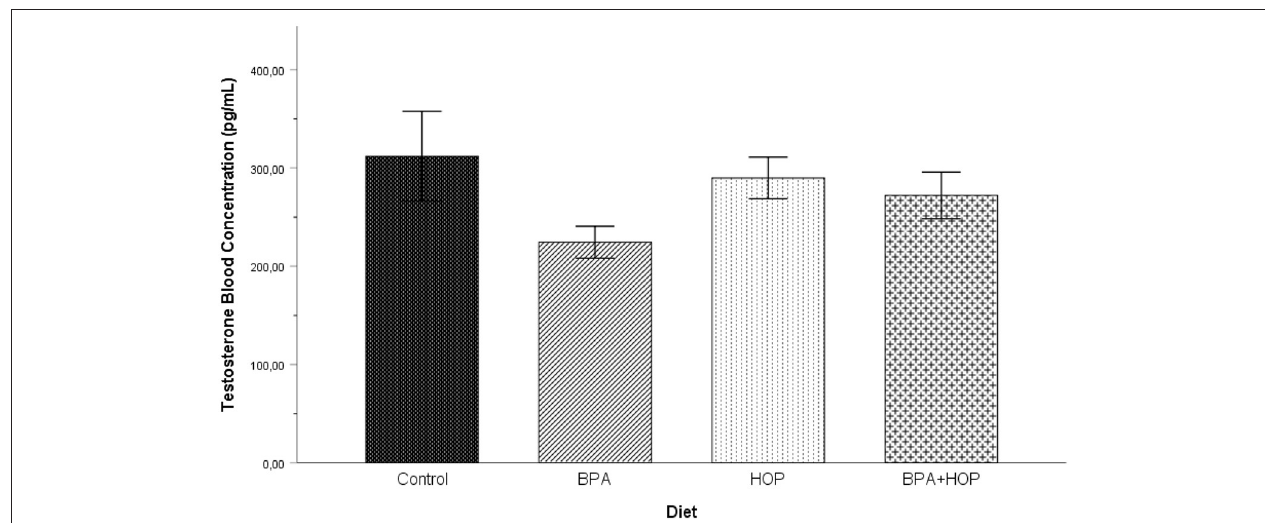
FIGURE 3 | Blood testosterone (T) levels were assessed on PND 71 (Control: n = 10; BPA: n = 10; Hop: n = 9; BPA-Hop: n = 9). No significant changes were detected between groups. Findings support a trend toward decreased T levels in BPA-treated rats. Data are represented as mean ± SEM.